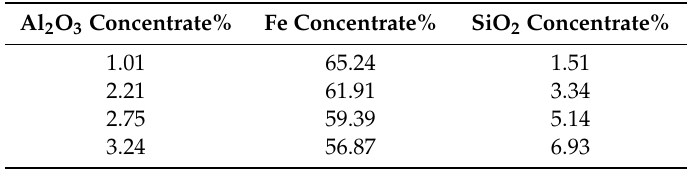
Table 7. Results of bench scale flotation tests with the products of the sedimentation tests of the iron ore slime (sample 1).